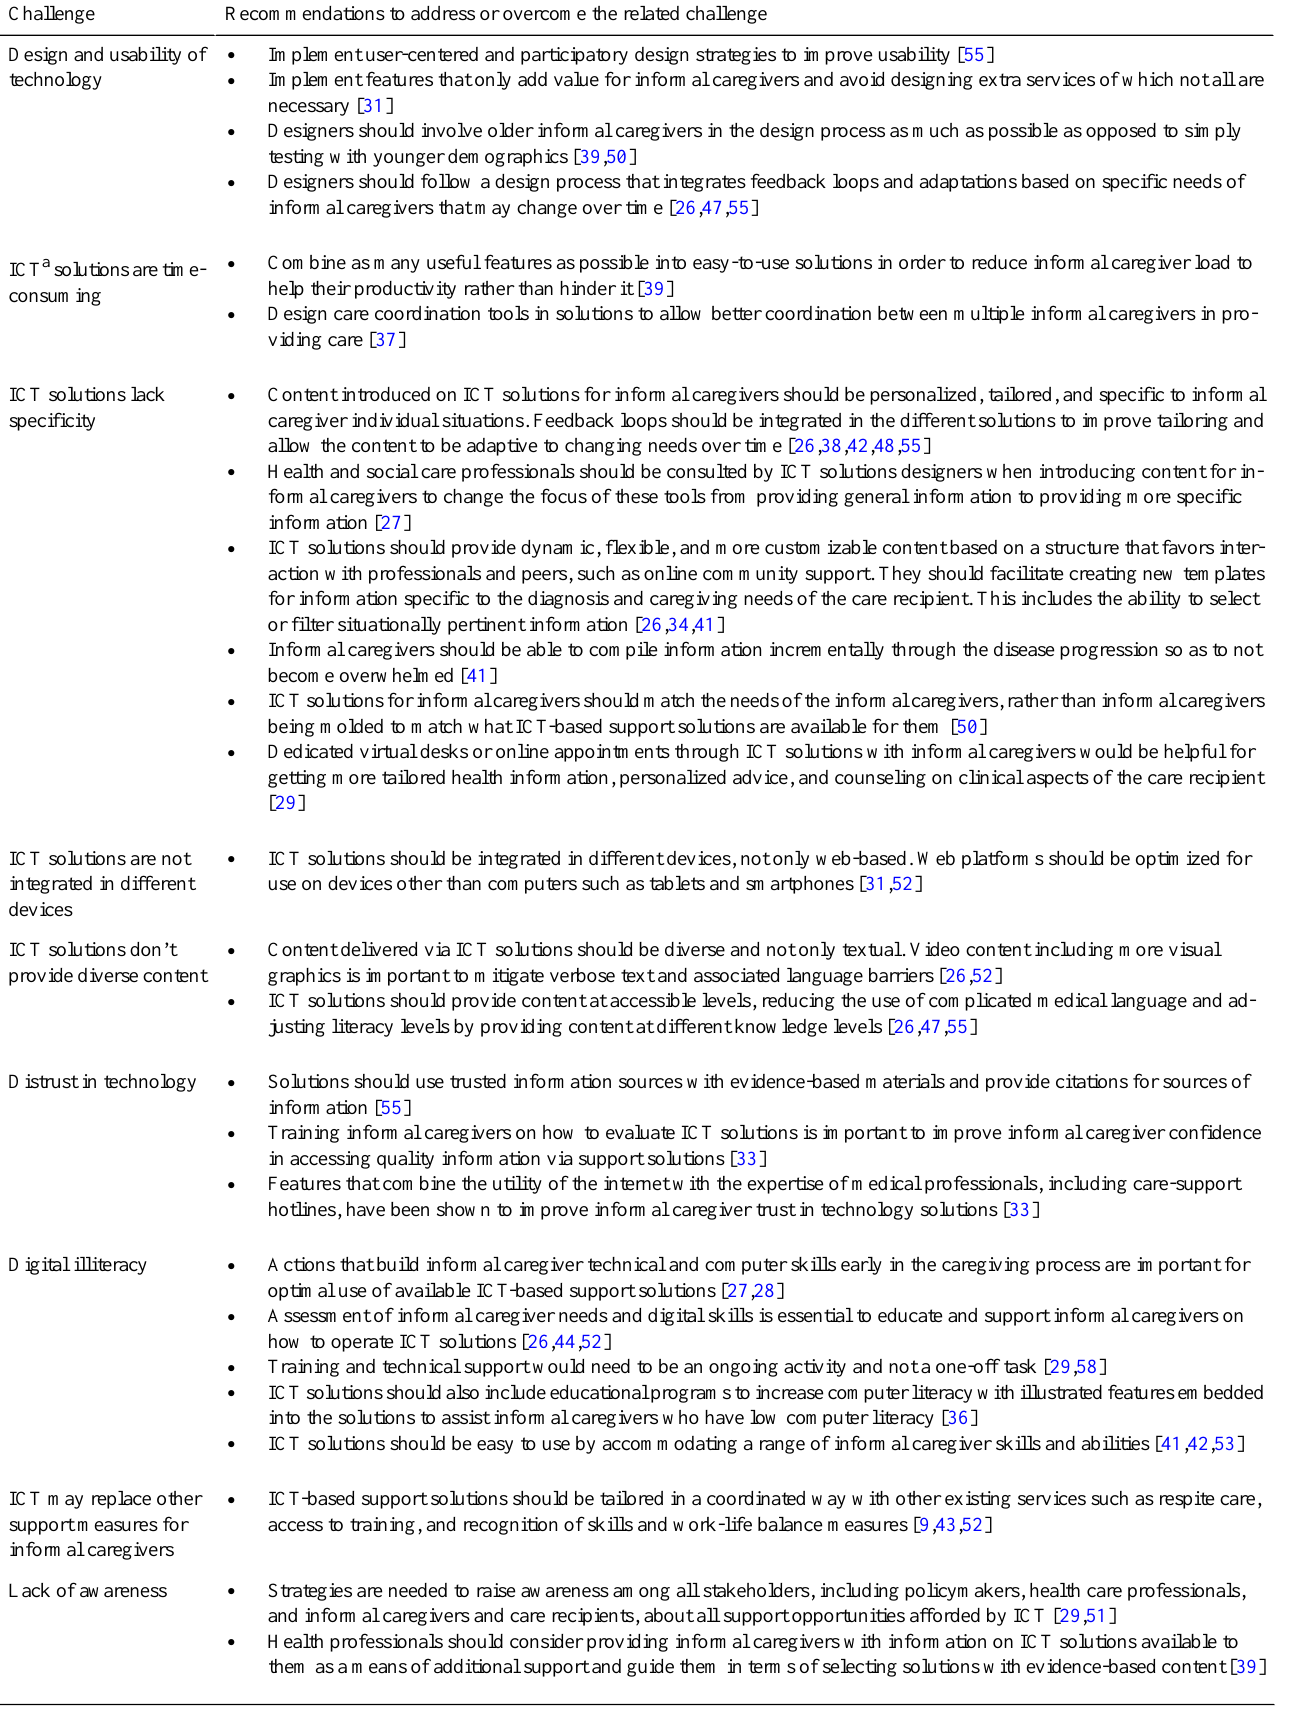
Table 4. Recommendations to overcome each of the identified challenges. Recommendations to address or overcome the related